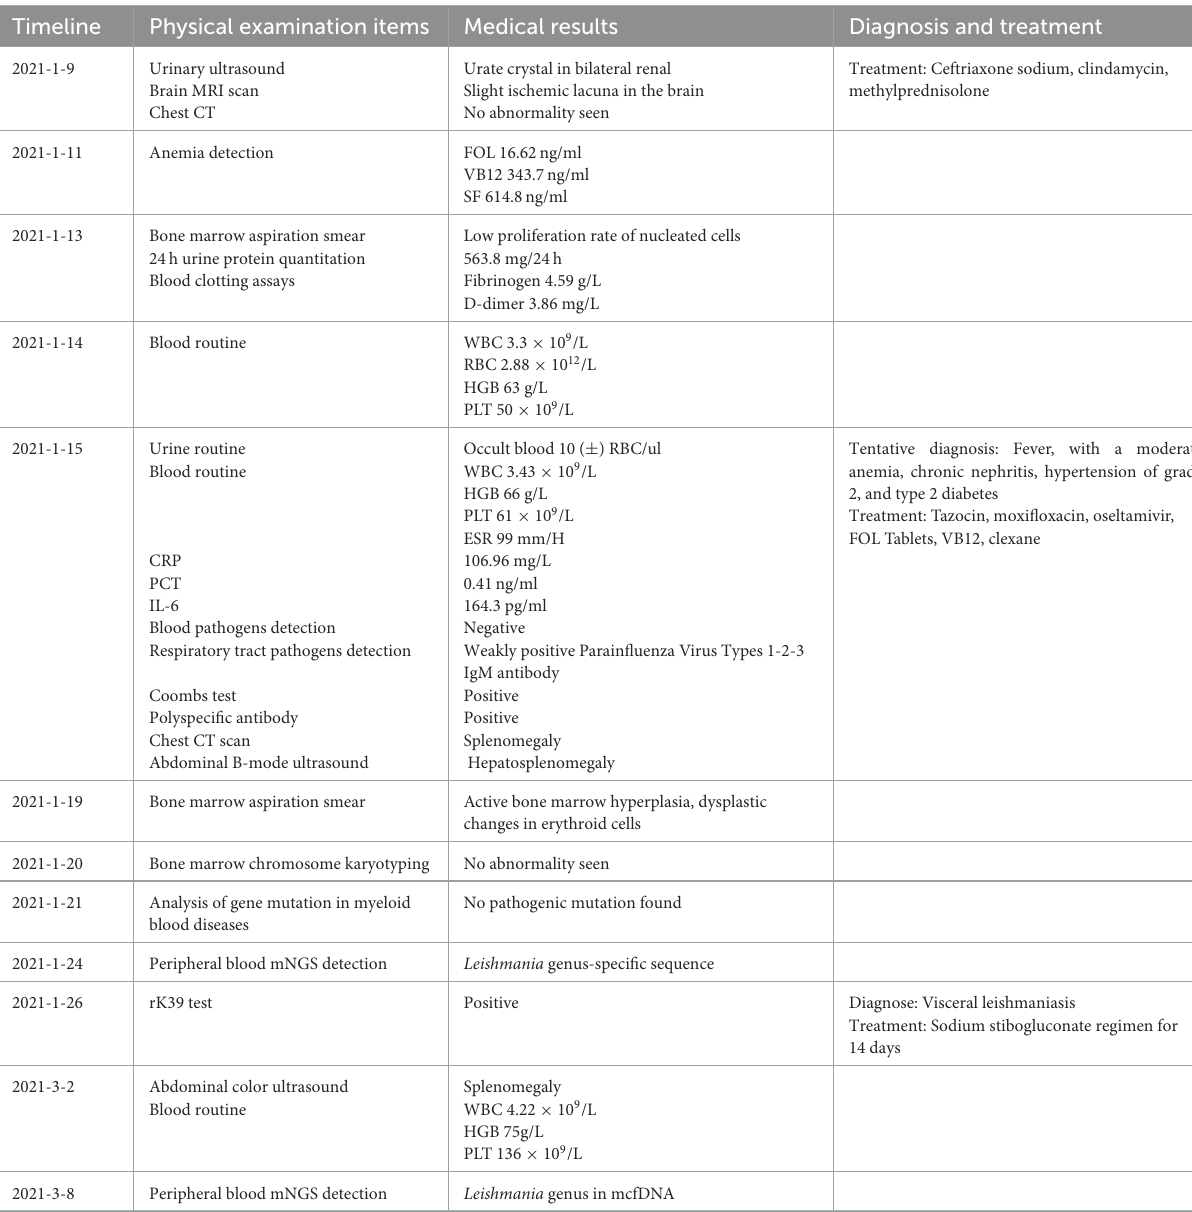
TABLE 2 Timeline of diagnosis and treatment in the case